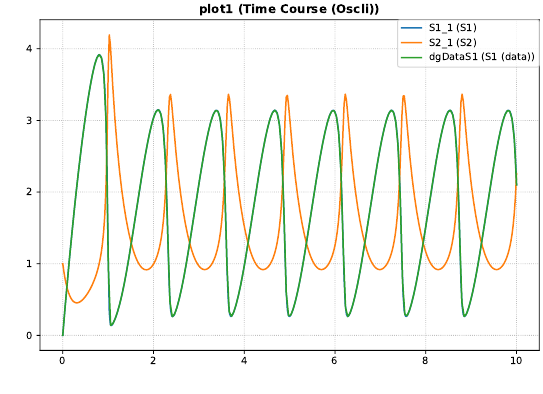
Figure A.1: The simulation result from the simulation description given in List- ing A.2. Simulation with SED-ML web tools [2].